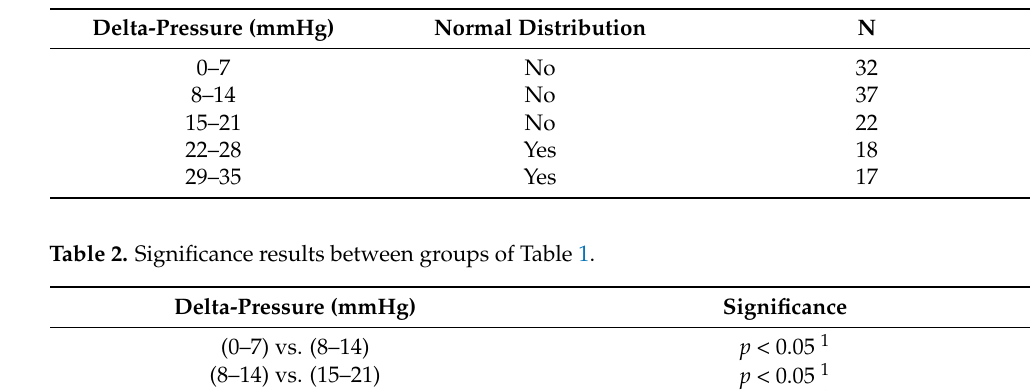
Table 1. Shapiro-Wilk test results on the difference between transducer intraocular pressure and Goldmann intraocular pressure (delta-pressure) grouped in five intervals.